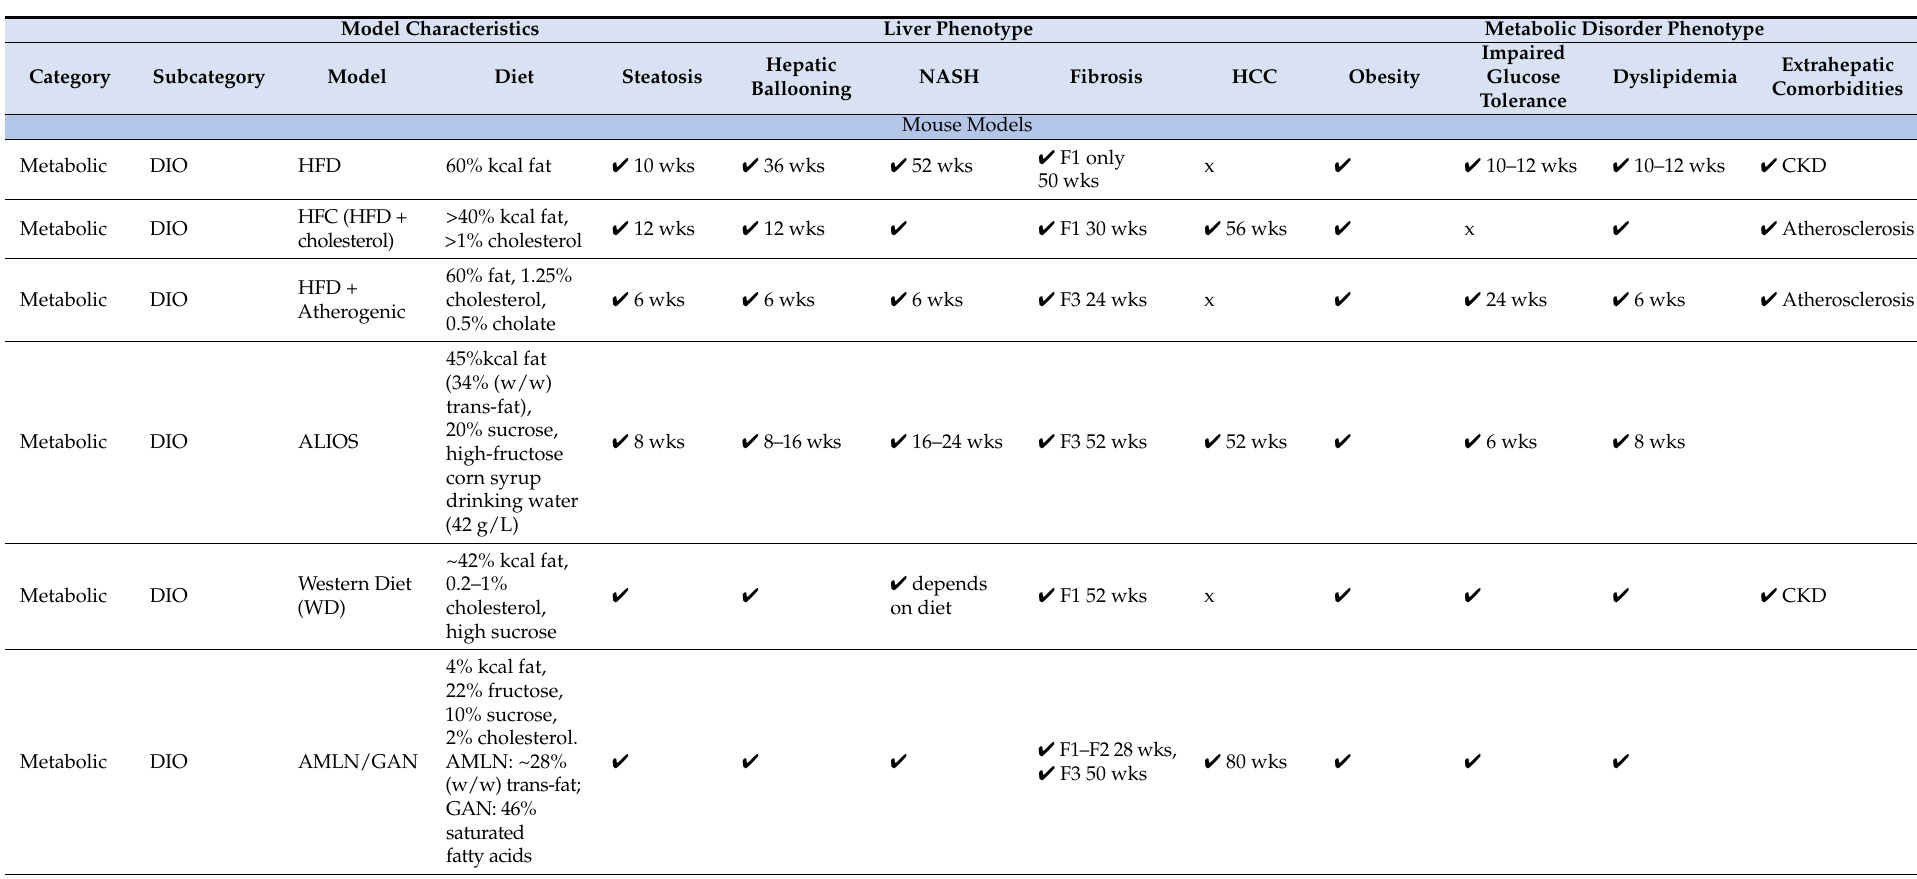
Table 1. Summary of commonly used animal models. Details of the animal models are compiled and reviewed from [171–182]. DIO refers to a diet-induced obesogenic diet; x refers to previous reporting of nonexistent features of the